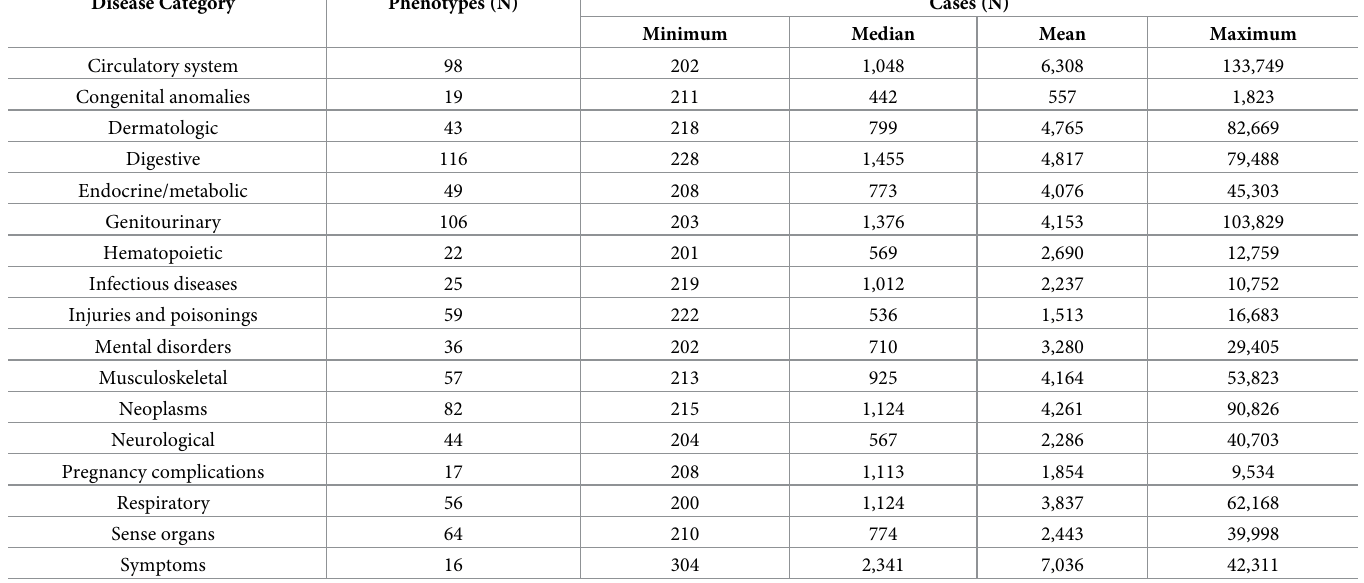
For the 19 outcomes reaching statistical significance at the 5% FDR threshold ( P < 1.1 × 10 − 3 ), scatter plots representing the SNP–serum iron and SNP–outcome association estimates are shown in S1–S5 Figs. Table 3 details the 14 traits for which there was consistent MR evidence (without suggestion of heterogeneity) across the 3 genetic instruments for a causal effect of higher iron status. Consistent results for these traits were obtained when per- forming the weighted median MR sensitivity analysis (Table 3) or scaling MR estimates to effects on the different biomarkers of iron status (S6 Table). S7 Table provides the MR odds ratio (OR) per 1 SD increase in genetically determined serum iron level, along with results stratified by sex. Similar estimates were obtained when considering males and females sepa- rately, with 95% confidence intervals (CIs) overlapping throughout, although there was some possible suggestion that the association with cellulitis outcomes was stronger for men (S7 Table). Higher iron status was most negatively associated with risk of acute posthemorrhagic ane- mia (OR per 1 SD increase in serum iron 0.35, 95% CI 0.19–0.65, P = 1 × 10 − 3 ). In the other direction, higher iron status was most positively associated with glossitis (OR 2.64, 95% CI Table 2. The number of phenotypes and cases considered in each disease